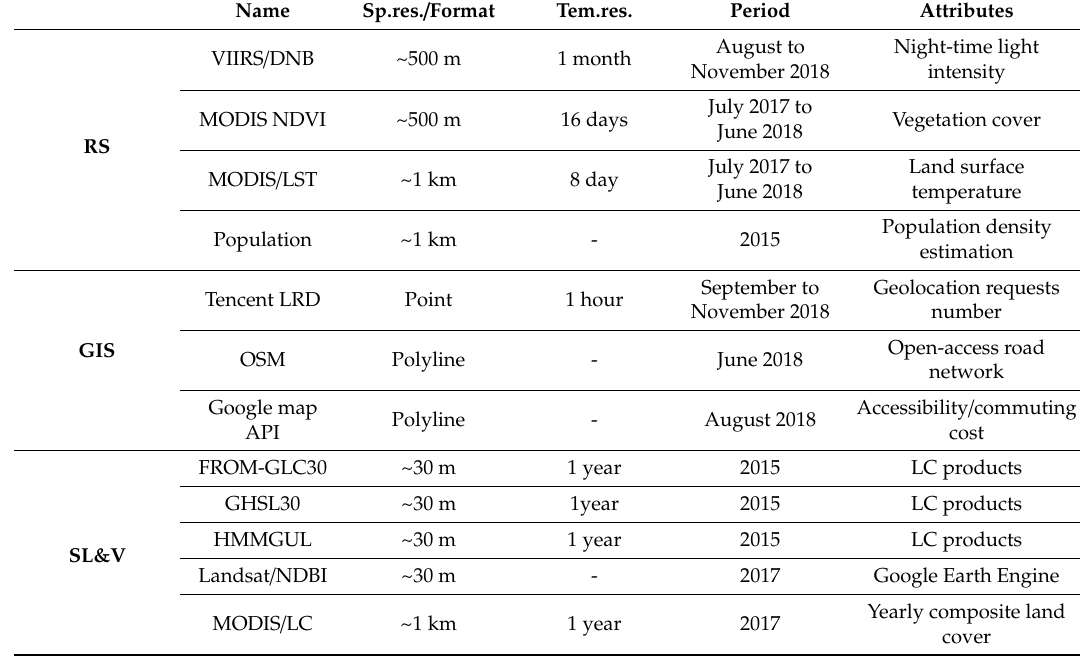
Table 1. The remote sensing (RS) and geographical information system (GIS) training datasets for feature selection, and the dataset for sample labeling and verification (SL&V). Information on a dataset contains the spatial resolution (Sp.res.) or the data format and temporal resolution (Tem.res.), acquisition period, and